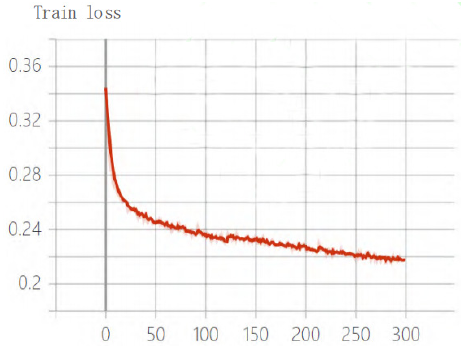
Figure 13. Training loss of the improved algorithm.